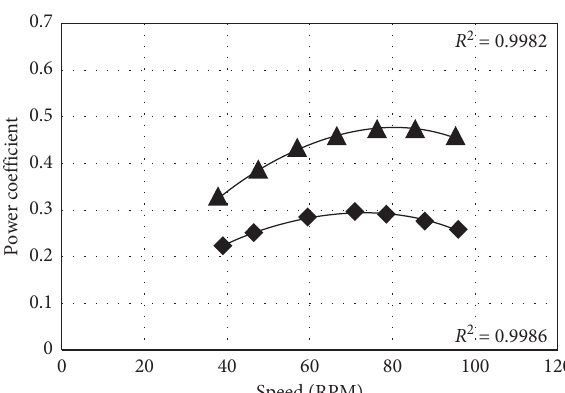
Figure 24: Runner 7 data points.